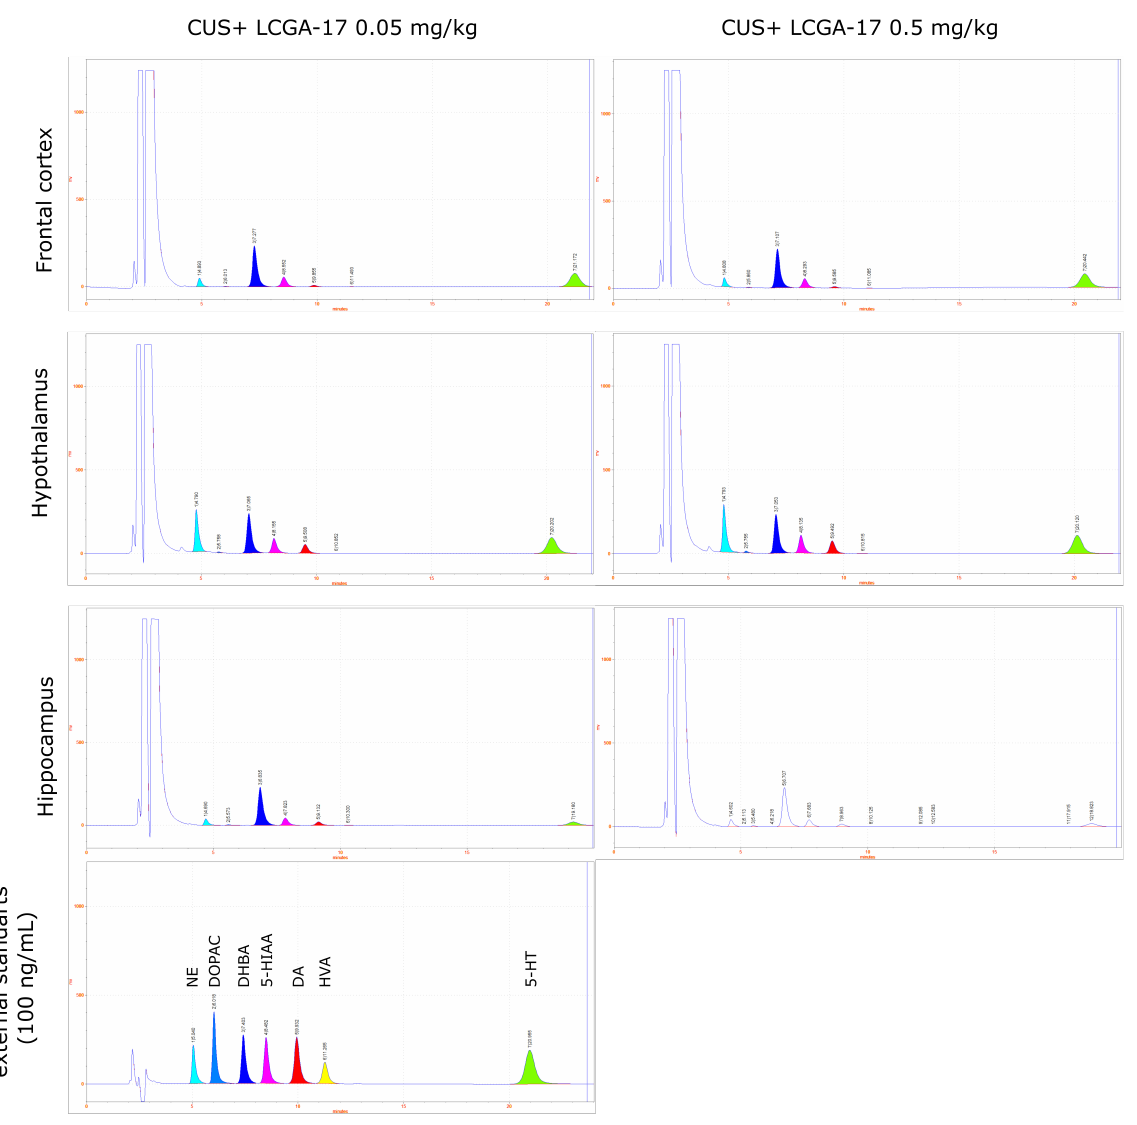
Figure 9. Example chromatograms of monamines NE, DA, and 5-HT and their metabolites (DOPAC, 5-HIAA, and HVA) extracted from the frontal cortex, hypothalamus, and hippocampus after CUS exposure and treatment with LCGA-17 (0.05 mg/kg and 0.5